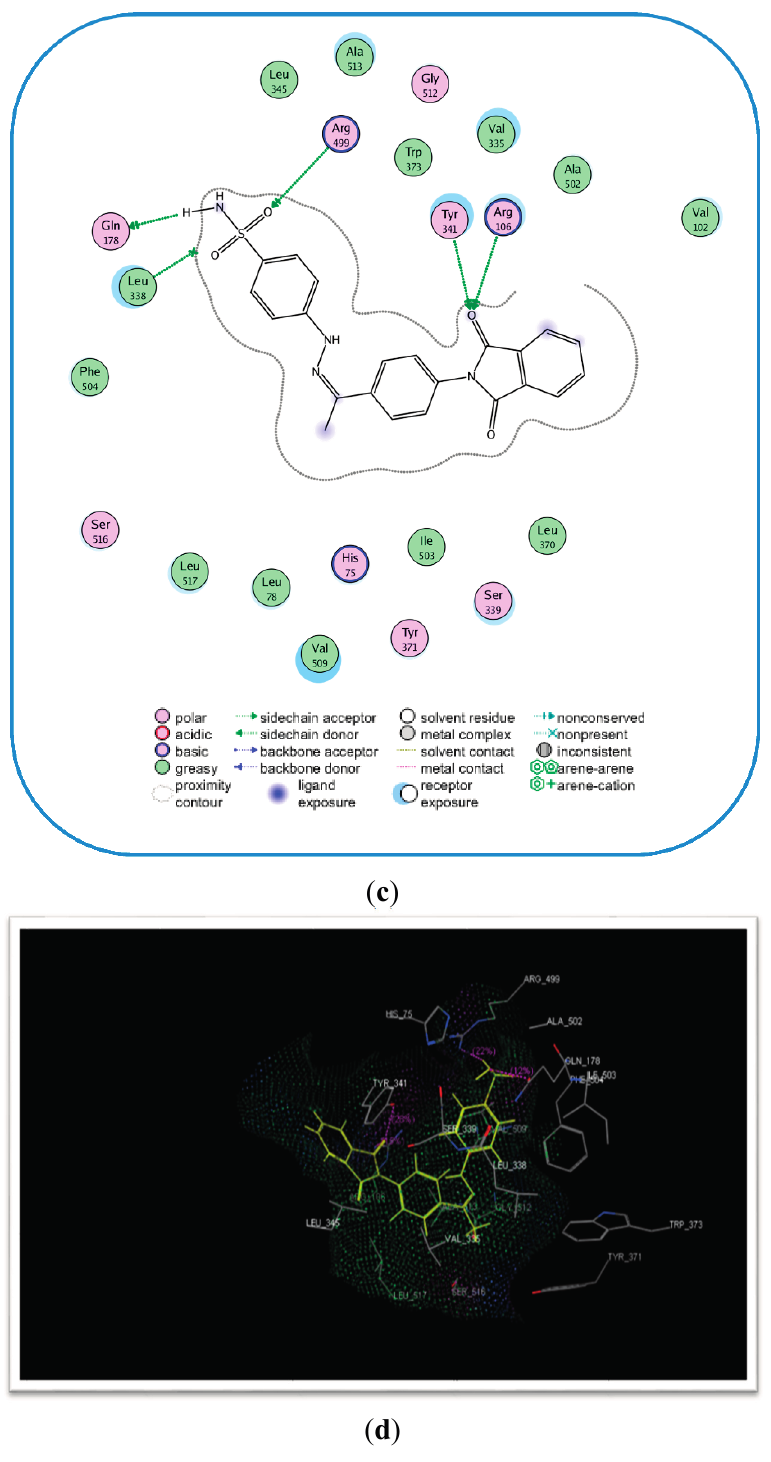
Figure 4. Binding of celecoxib ( 6 ) and the most active compound 17c inside COX-2 active site. ( a ) 2D Interaction for binding of celecoxib ( 6 ) inside COX-2 active site, the most important amino acids are shown together with their respective numbers; ( b ) 3D interaction of celecoxib ( 6 ); ( c ) 2D interaction for binding of the most active compound 17c inside COX-2 active site, the most important amino acids are shown together with their respective numbers; ( d ) 3D interaction of 17c